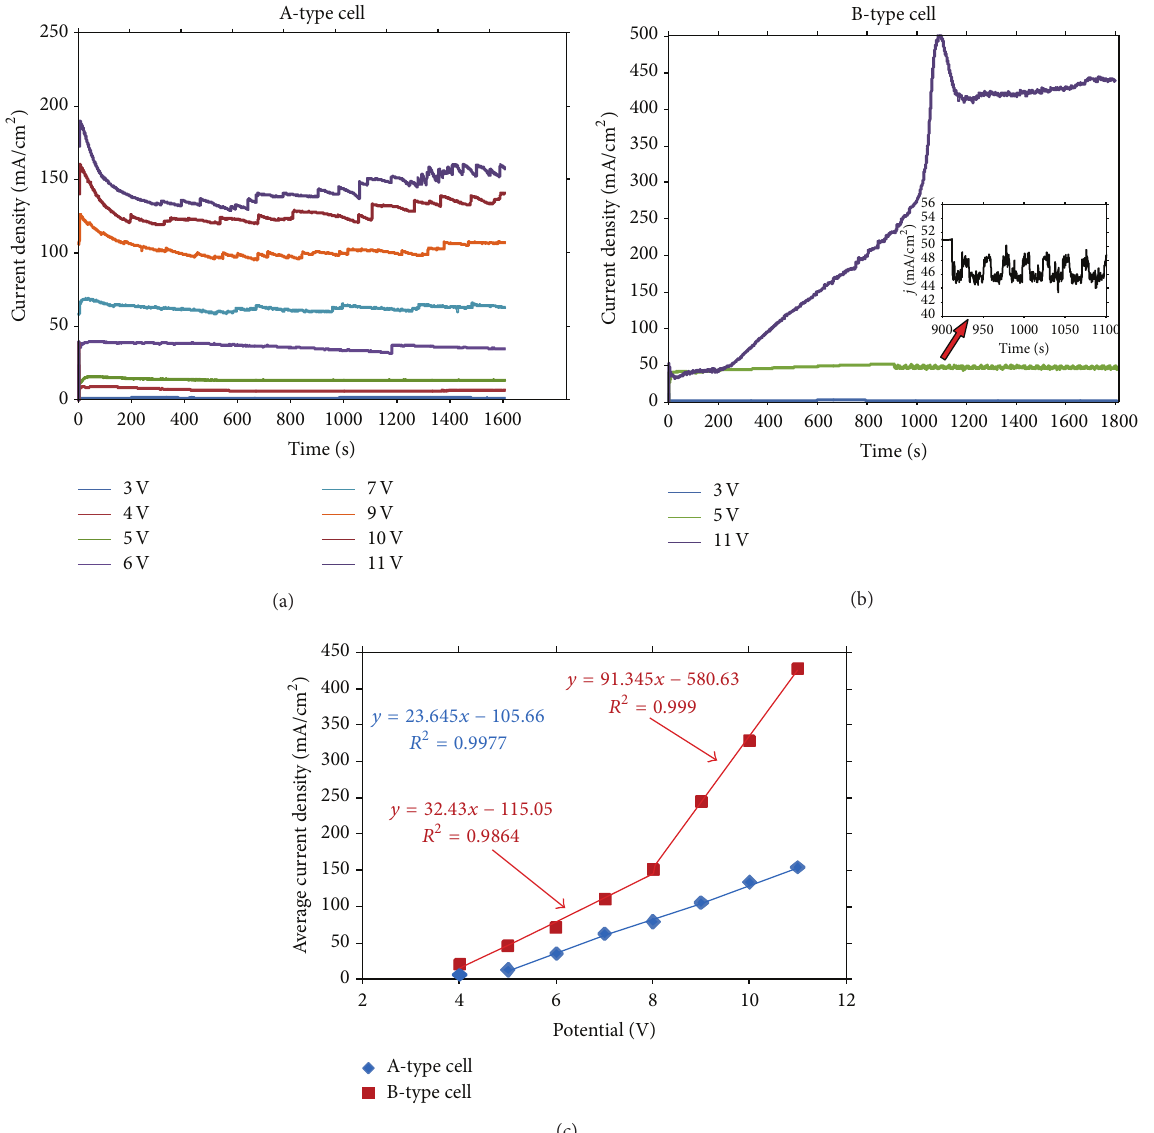
Figure 4: Current density versus time curves recorded during anodization of low-purity Sn in the A-type (a) and B-type cells (b) at various anodizing potentials together with the dependence between an average steady-state current density and anodizing potential (c).